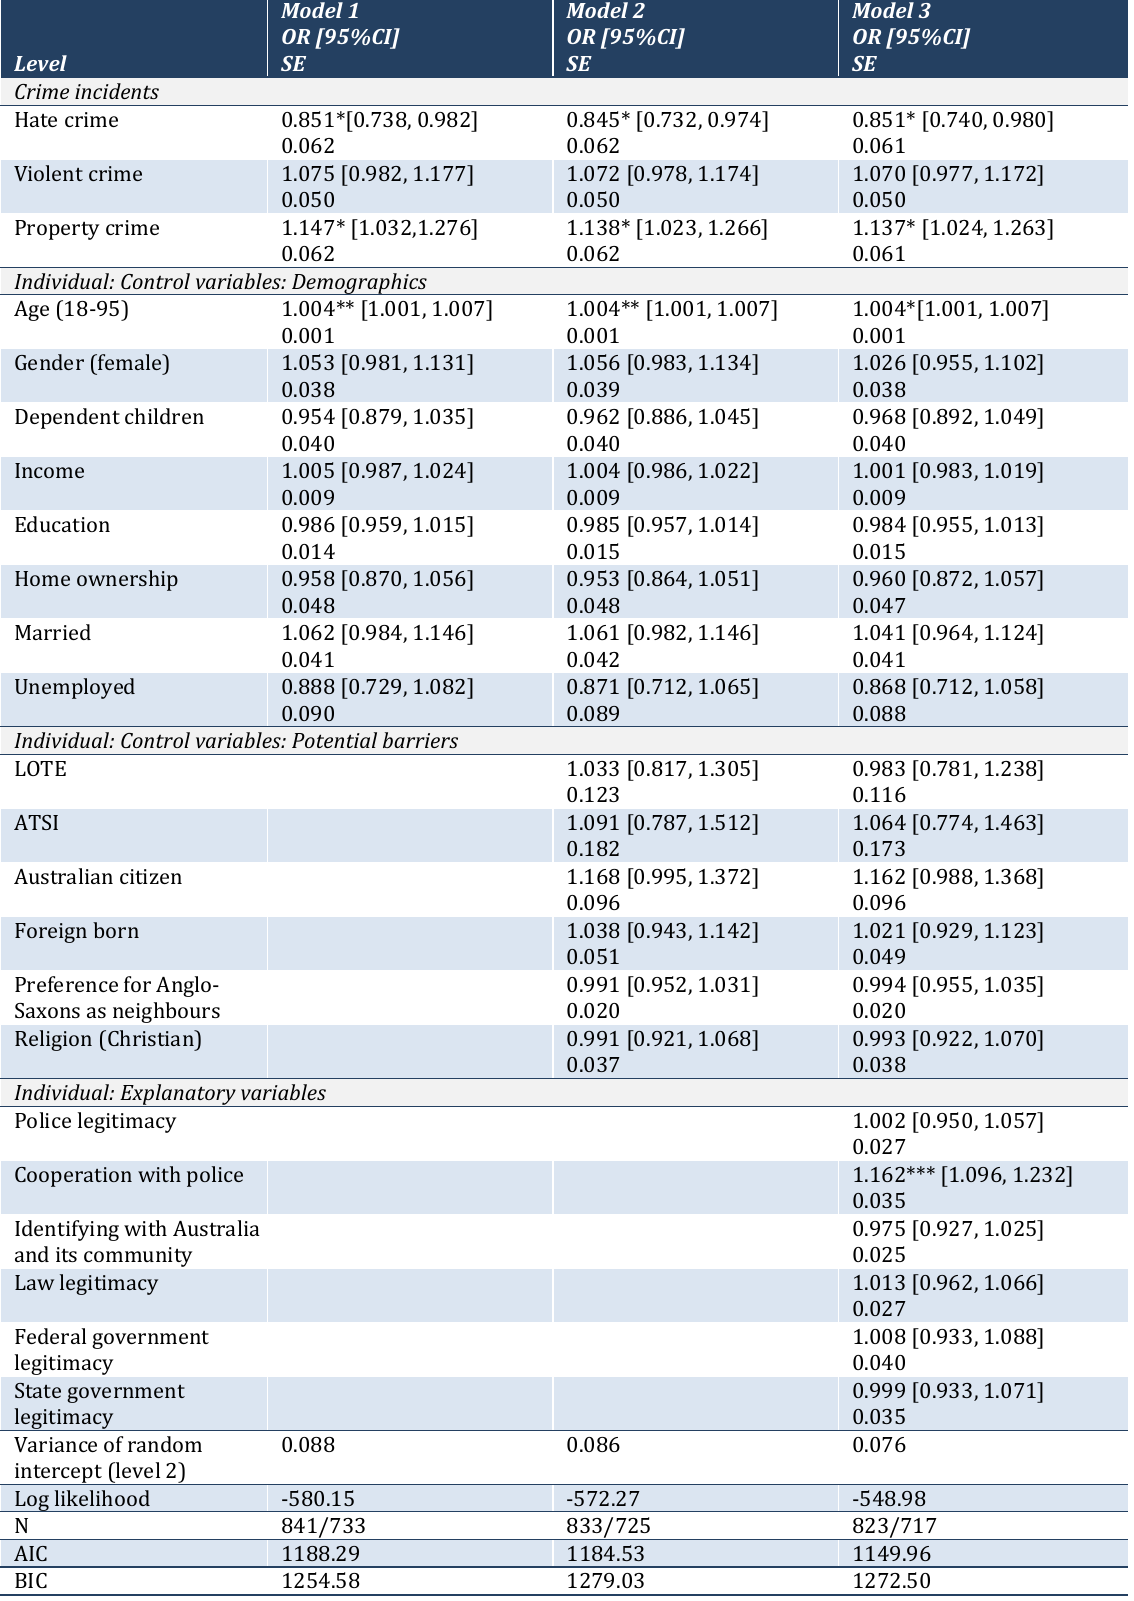
Table 2: Gllamm models indicating the likelihood of reporting crime incidents to